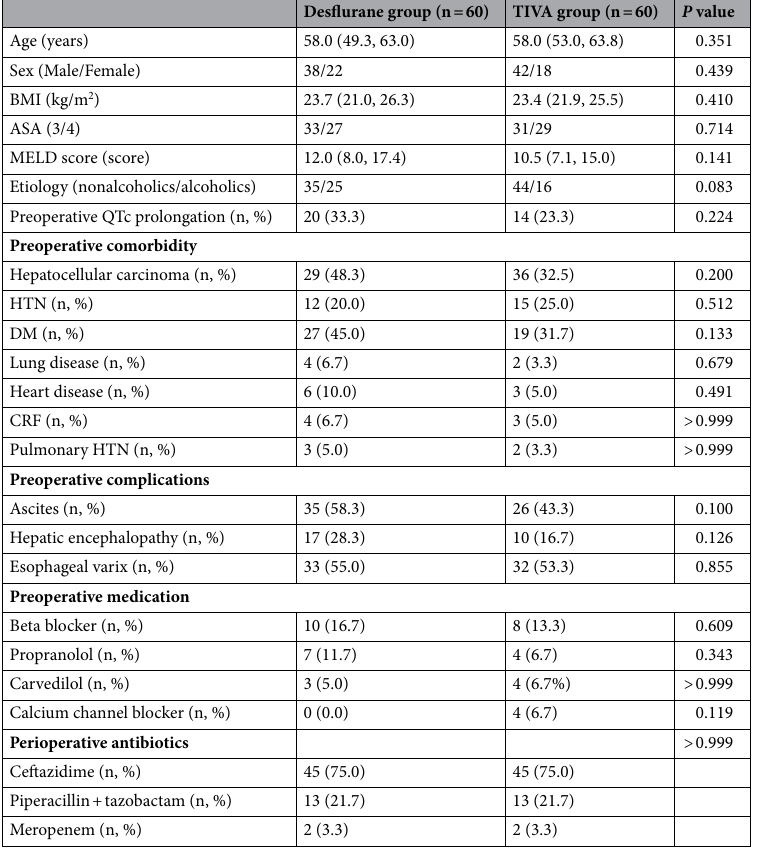
Table 1. Baseline patient characteristics. Data are presented as median (interquartile range) for continuous variables and count (percentage) for categorical